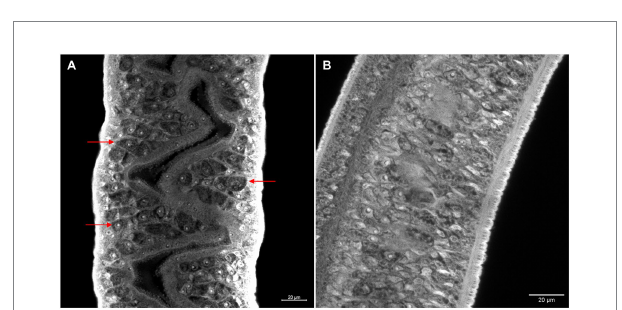
FIGURE 7 Morphology of ex vivo Sm carm 1 knocked-down female adult worms. Morphological changes in the vitelline glands of female adult worms recovered from mice infected with schistosomula from (A) negative control and (B) Sm carm 1-dsRNA. Red arrows highlight the cell organization of the vitelline glands and white bars indicate the scale 20 μ